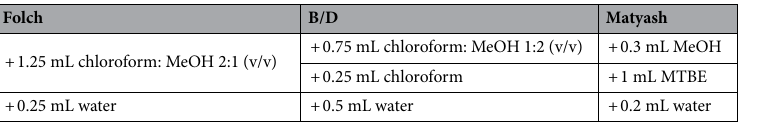
Table 1. Composition and ratio of the solvents used in the three different FFA extraction methods